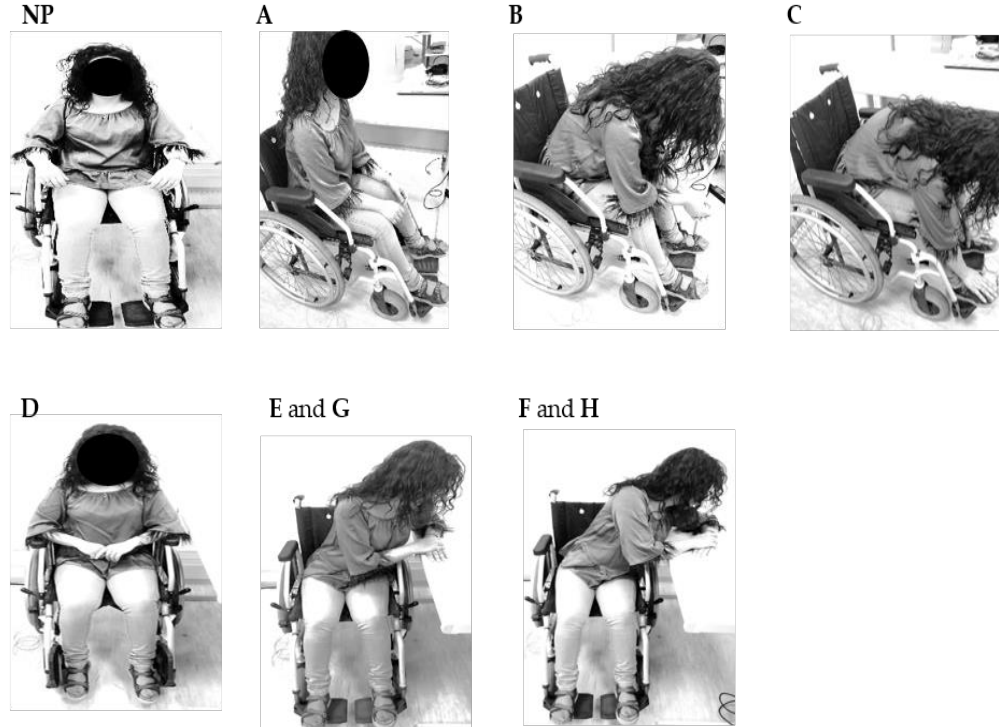
Figure 5. Representation of the nine positions adopted during the pressure relief tests.